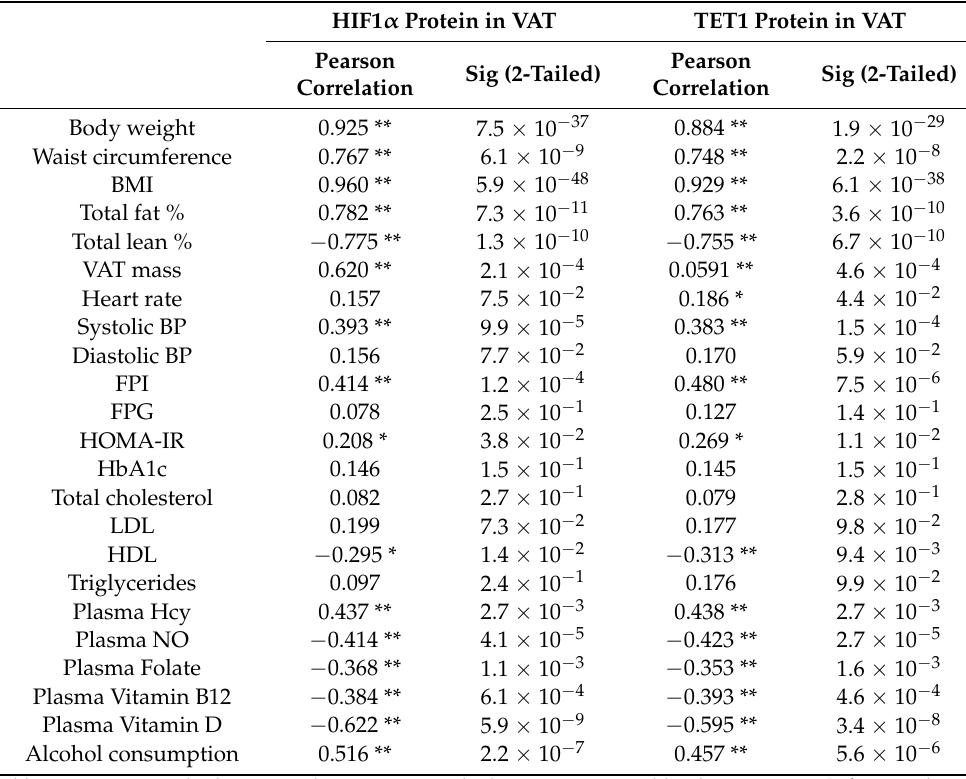
Table 3. Correlations between HIF1 α and TET1 protein levels and cardiometabolic risk factors. HIF1 α Protein in VAT TET1 Protein in VAT Pearson Sig (2-Tailed) Correlation